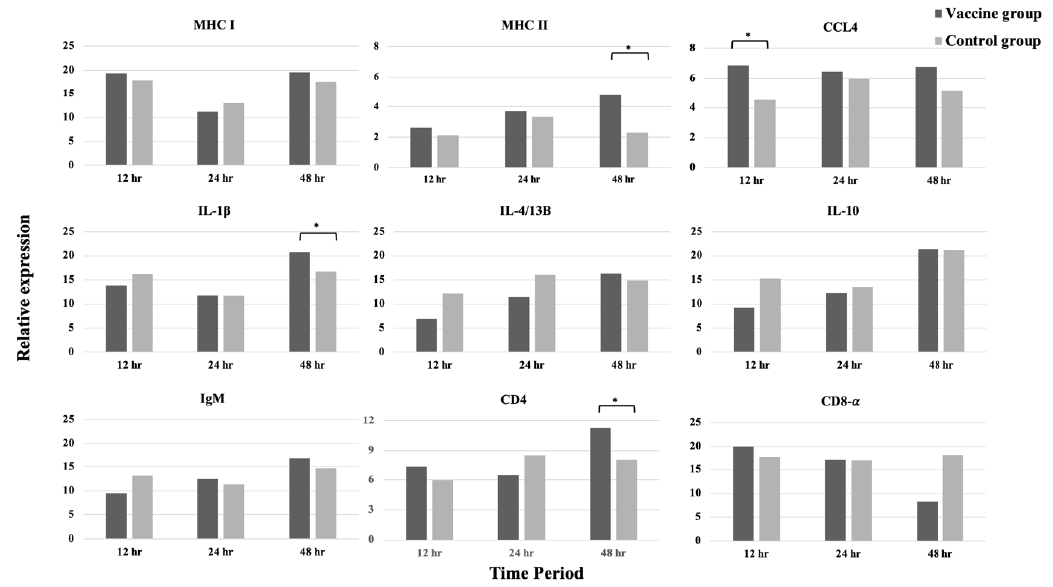
Figure 3. Expression profiles of immune-related genes in the vaccinated and control fish at 12, 24, and 48 h post-vaccination (* p < 0.05).